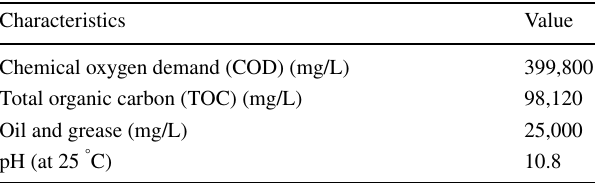
Table 1 Characteristics of biodiesel wastewater